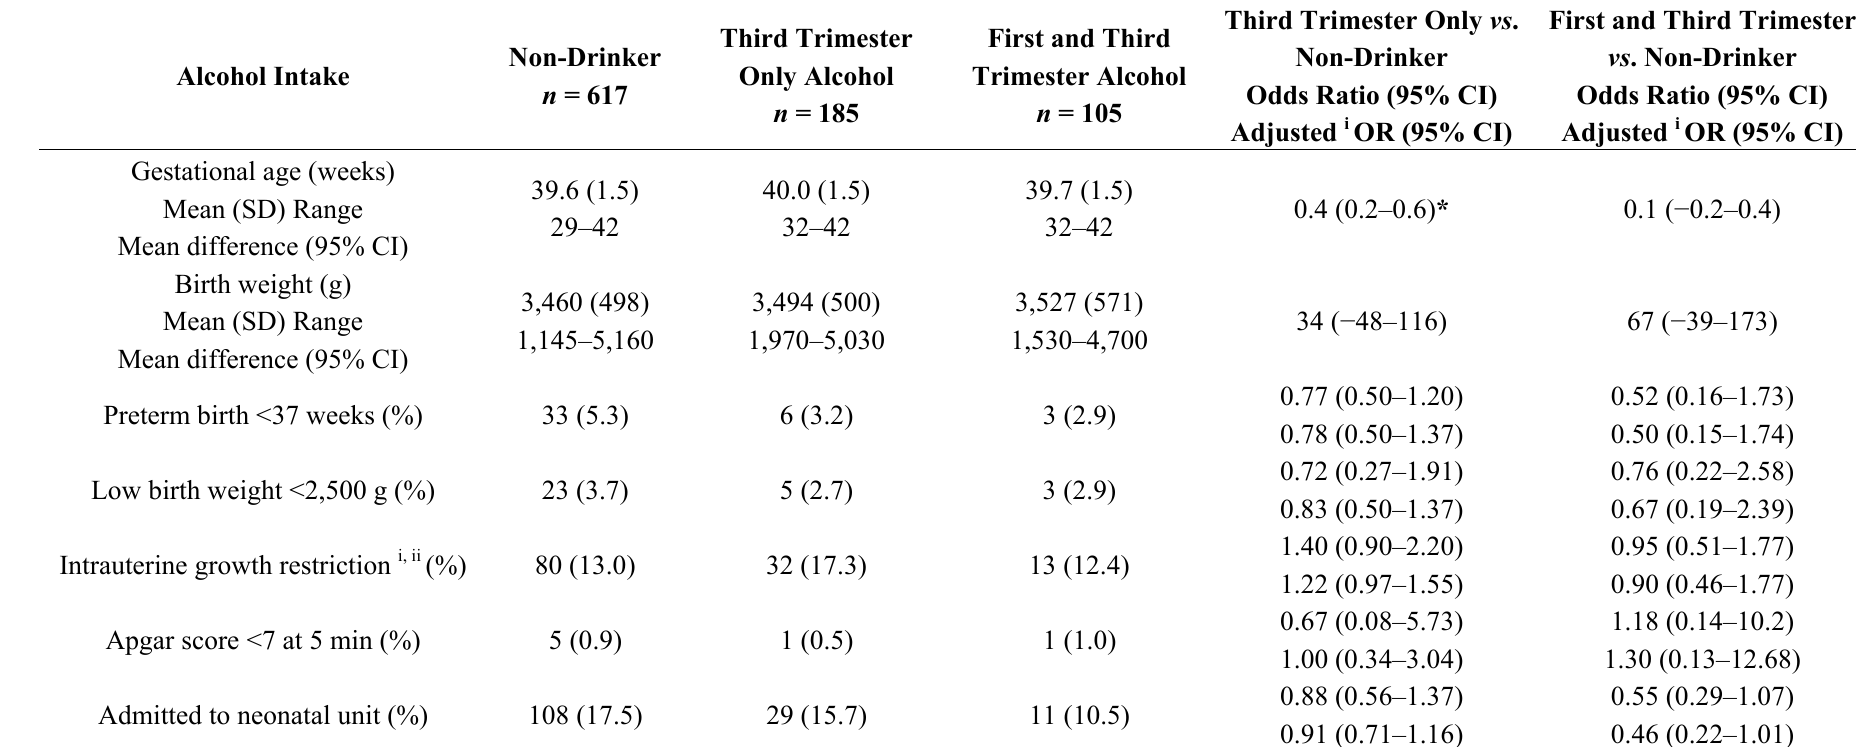
Table 4. Perinatal outcomes according to alcohol exposure in first and third trimester of pregnancy and third trimester